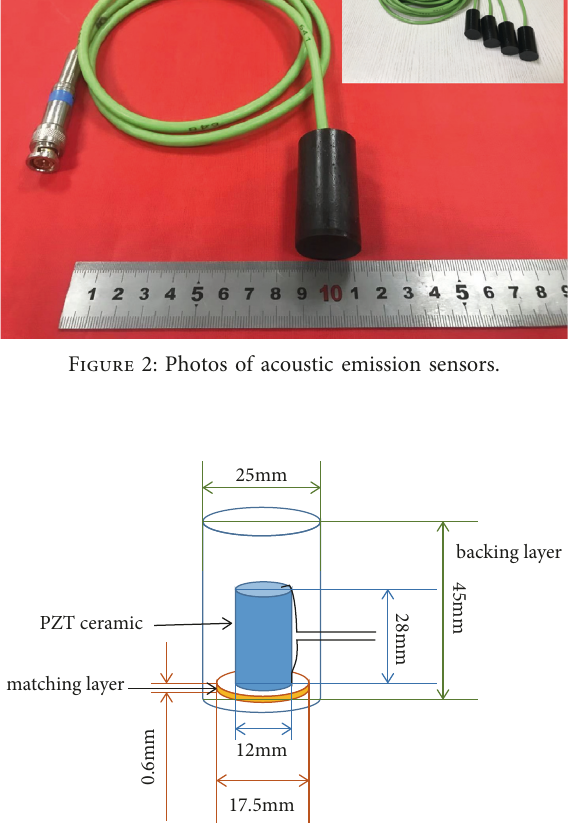
Figure 3: Structural diagram of acoustic emission sensor.